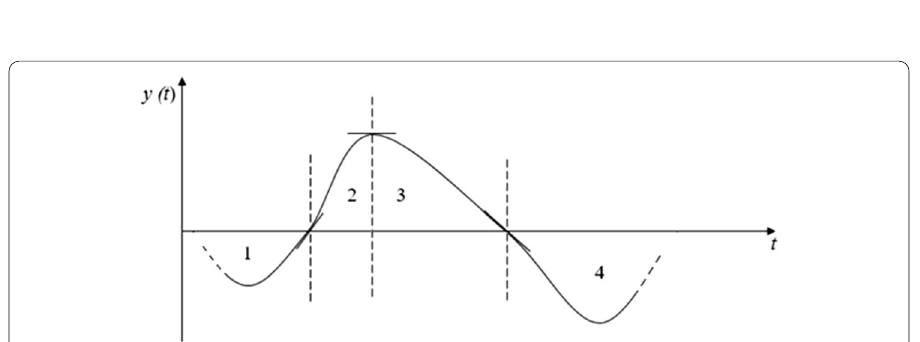
Fig. 6 Representation of basic